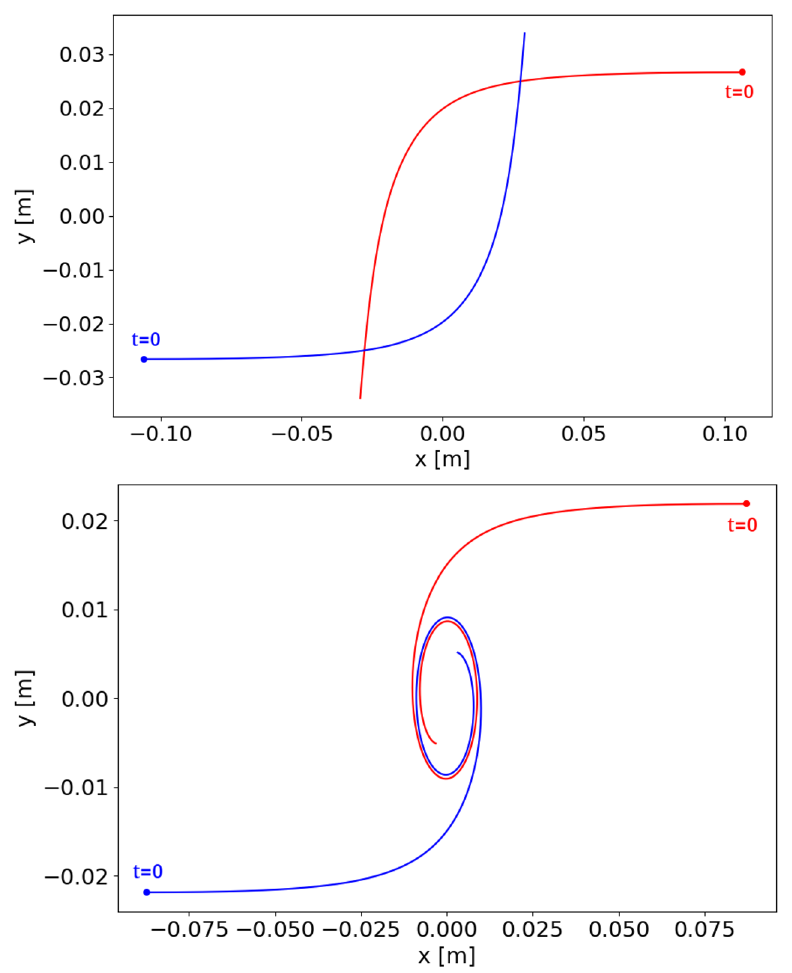
Figure 5. Gravitons trajectories represented by the blue and red lines. In the top panel, the initial impact parameter is larger than the critical value b hor and the gravitons scatter o(cid:11) each others. In the bottom panel, b < b hor and the gravitons start to spiral around each others, thereby forming a bound object. Videos associated to these trajectories are available in the supplementary